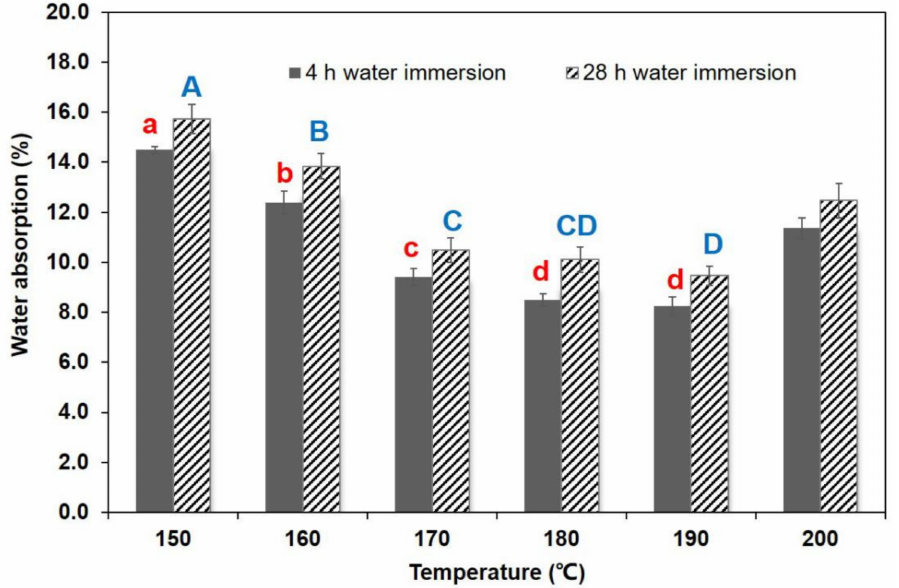
Figure 4. Water absorption results at different hot press temperatures (Notes: The same lowercase (4 h water immersion) and capital letter (28 h water immersion) are not significantly different at 5% significance level using Duncan’s post-hoc